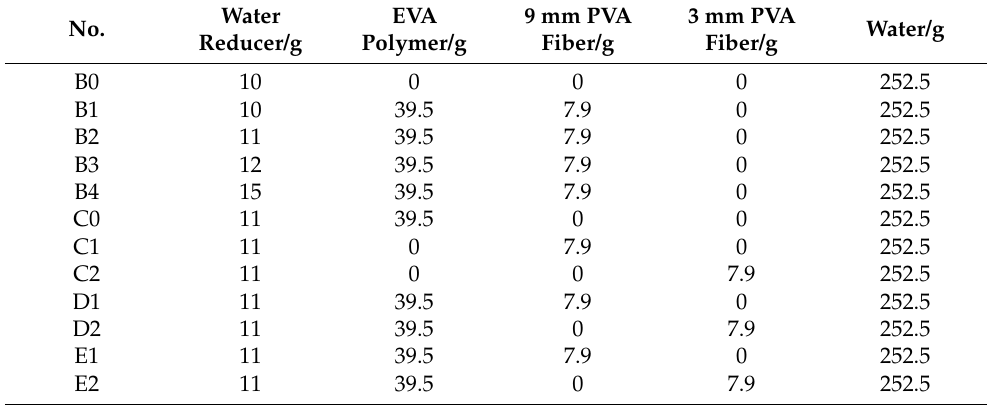
Table 8. Mix ratio of